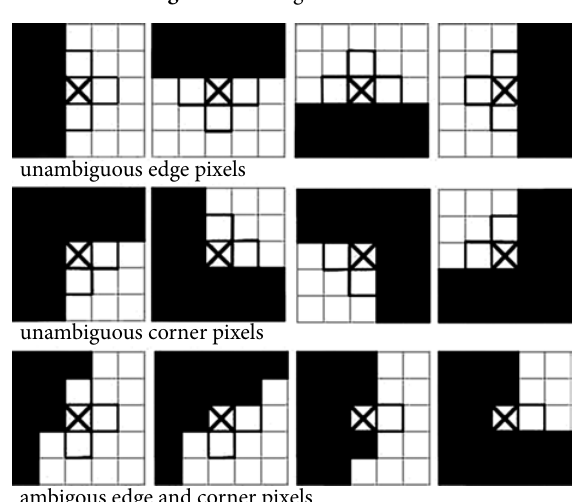
Fig. 6. Template for edge features